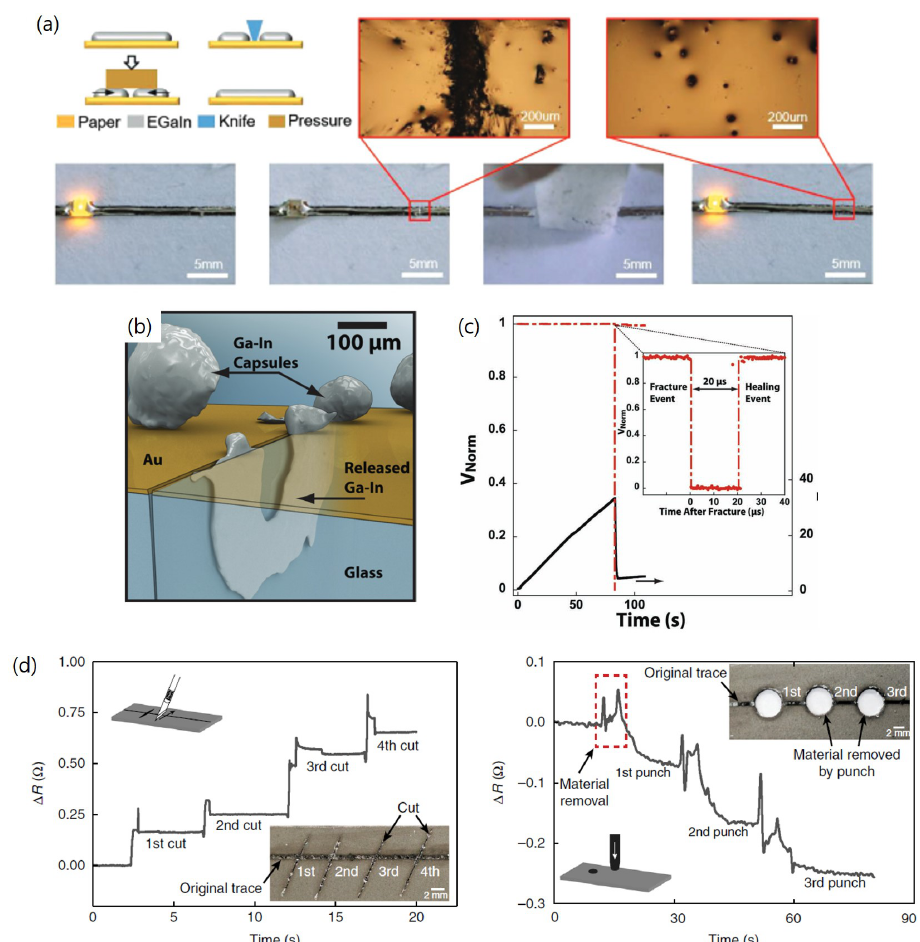
Figure 13. ( a ) Self-healing procedures and corresponding photographs of a liquid metal circuit. The liquid metal circuit damaged by knife is recovered by applying pressure. Reproduced with permission from [60]; published by John Wiley and Sons, 2019. ( b ) Illustration showing the crack in a thin gold film on glass repaired by released EGaIn capsules. ( c ) Normalized bridge voltage (red) and force (black) measurements recorded during the four-point bending test of a self-healing specimen. Reproduced with permission from [80]; published by John Wiley and Sons, 2019. ( d ) Measured resistance changes of liquid metal patterns damaged by razor blade cutting (high aspect ratio damage, left) and by hole punching (low aspect ratio damage, right). Reprinted by permission from Springer Nature: [81], Copyright